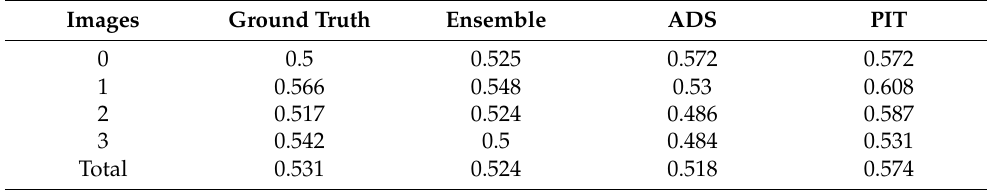
Table 2. Summary of the G-ratios calculated from the ground truth testing images and for the corresponding predicted images of the ADS, PIT, and ensemble